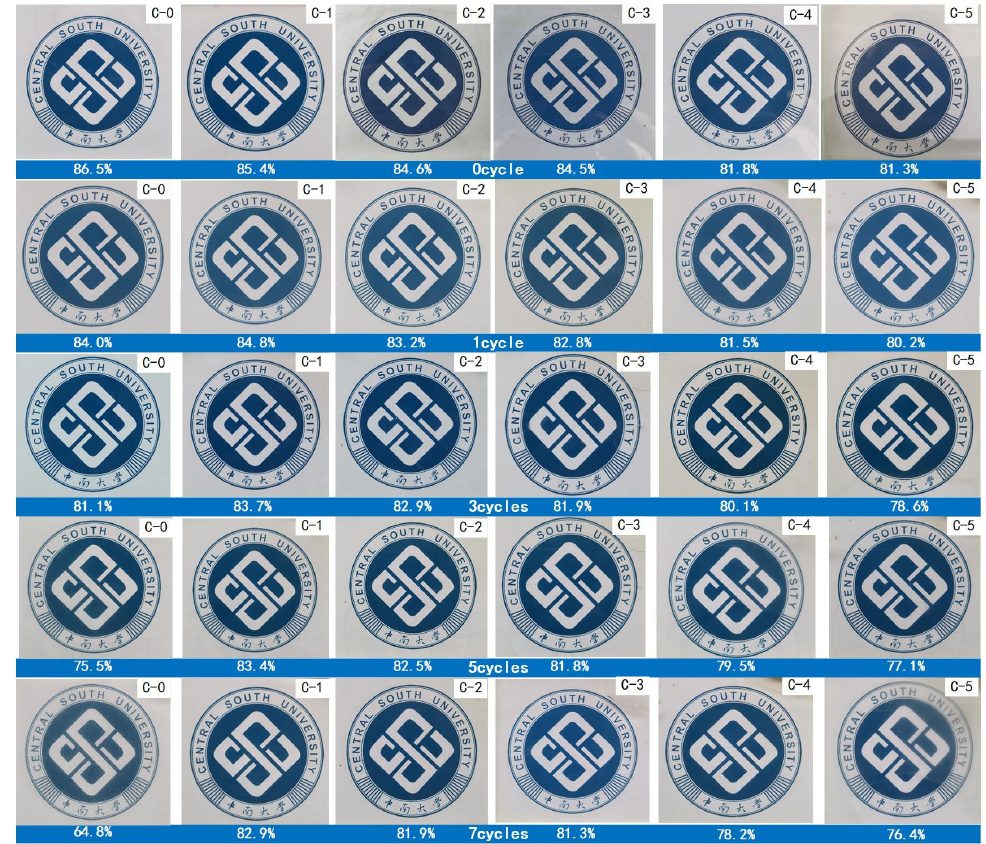
Figure 10. Digital photos and light transmittance of samples at different aging cycles.